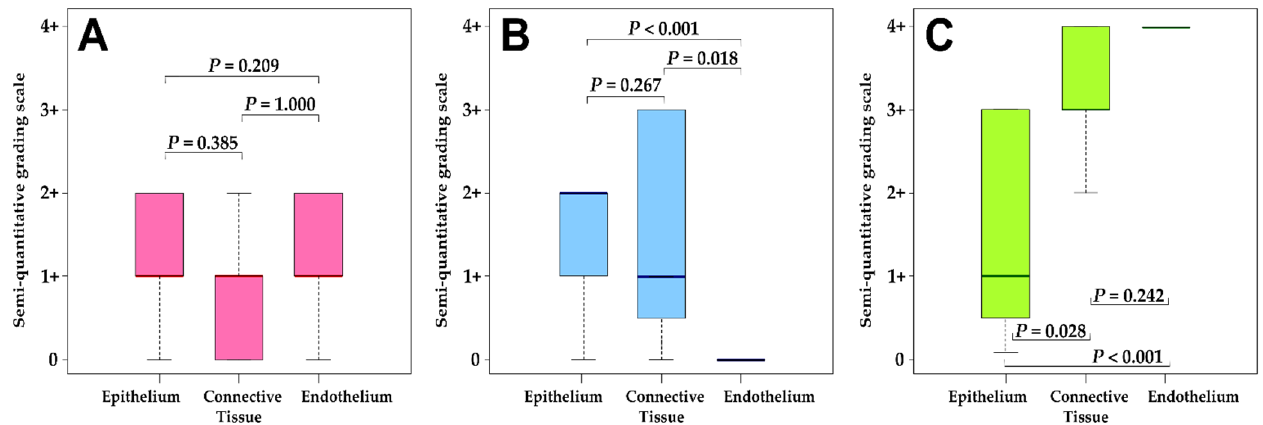
Figure 2. Distribution of semi-quantitative grading for IHC staining for ( A ) bFGF , ( B ) FGFR1 , and ( C ) FOXE1 . The adjusted P values indicated were obtained using the post hoc tests from the Kruskal–Wallis ANOVA test. An interpretation of the grading scale is shown in Table 2.